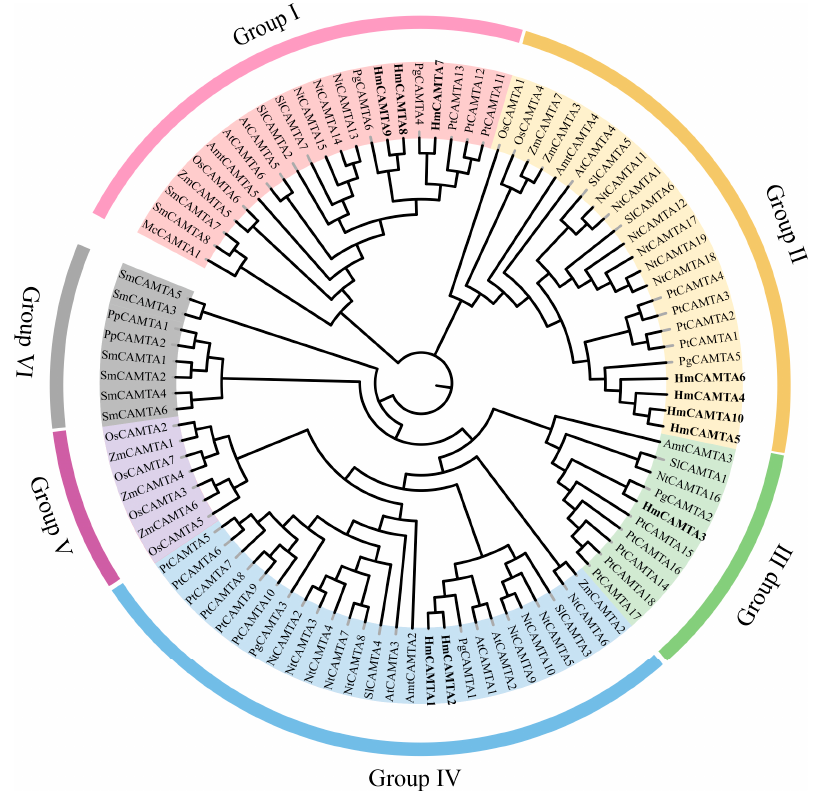
Figure 5. Phylogenetic tree of CAMTA family. Each subgroup is distinguished by a different color.